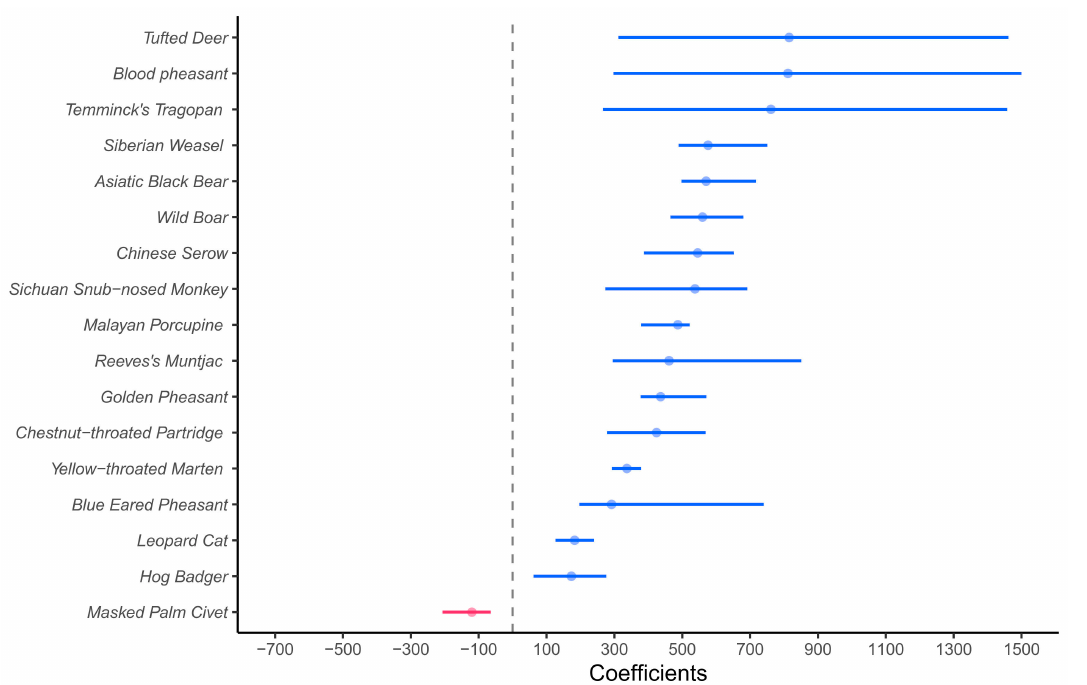
Figure 2. Coefficient plot displaying the regression coefficients of zero-inflated generalized linear mixed models (ZINB) comparing independent events of wildlife at BC and sites far from roads. Solid circles indicate the estimated coefficients for events in the models, their 95% confidence inter- vals are presented by the solid line, and the vertical dashed line indicates the value of 0. The color blue means that the count of independent events at sites far from roads was significantly higher than those at BC (the lower limit of confidence interval was greater than 0). The color red indicates